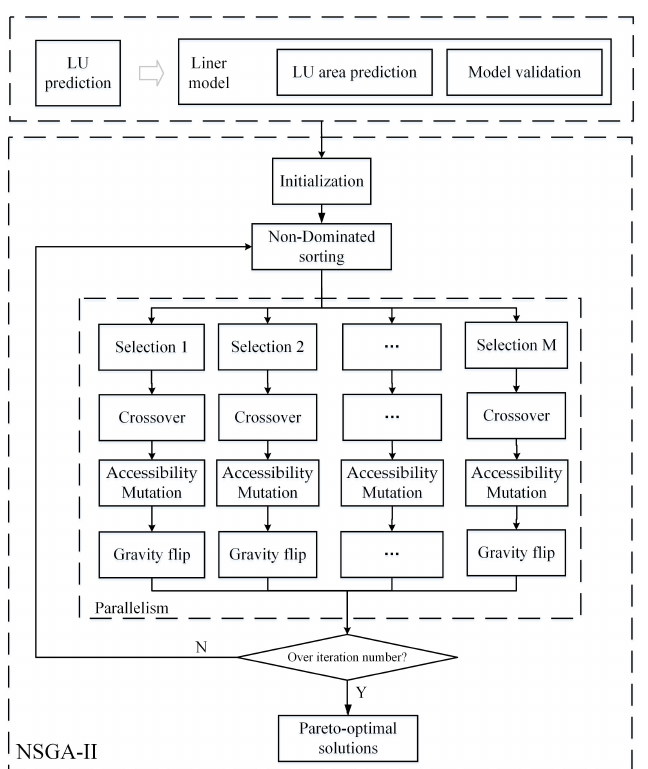
Figure 3. Workflow procedure of the multi-objective NSGA-II land use optimization framework to derive Pareto-optimal solutions. A linear prediction of past land use was used to provide future land use initialization constraints. The NSGA-II algorithm was then applied using non-dominated sorting, cross-over, accessibility mutation, and gravity flip operators, which are described in the main